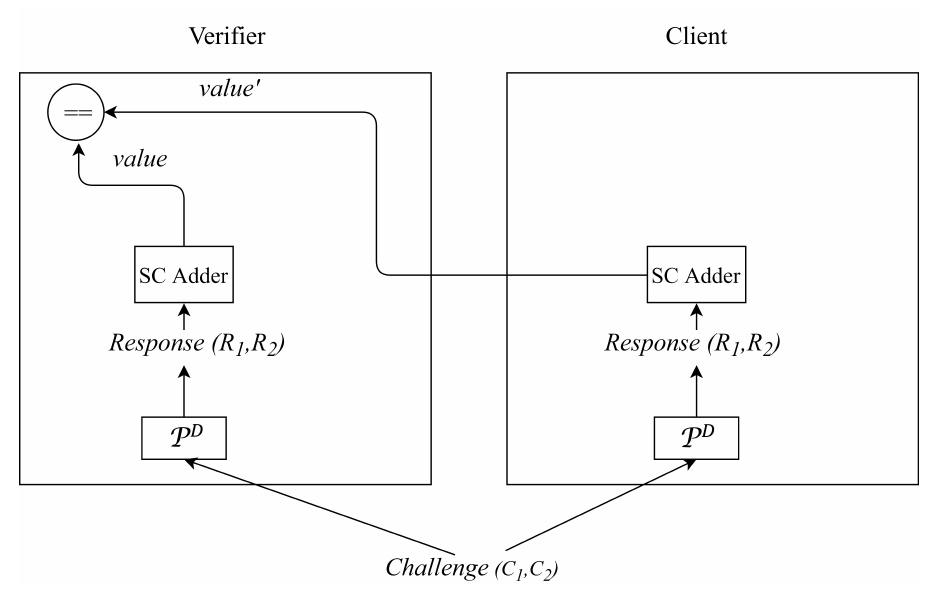
Figure 10. Flow chart of the authentication model based on stochastic logic